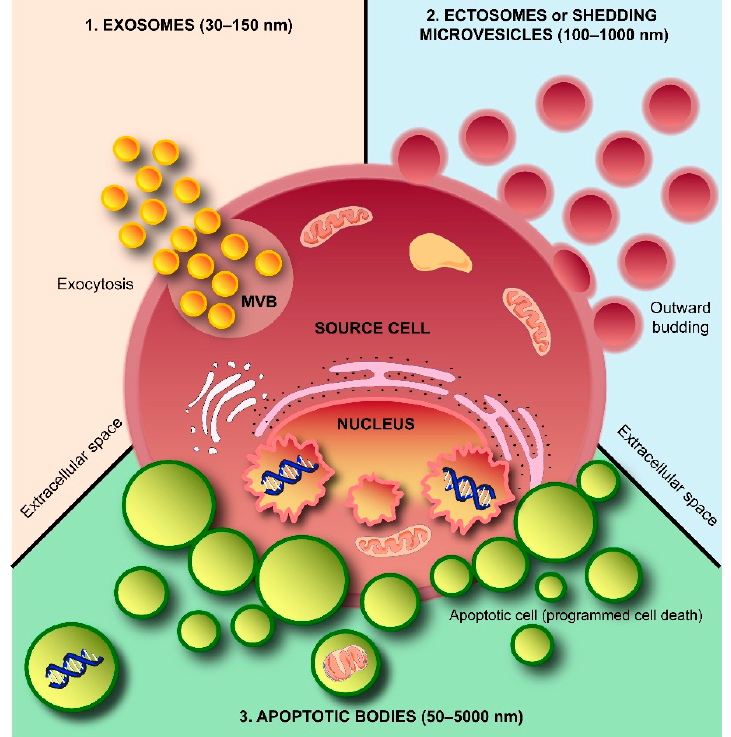
Figure 1. Schematic representation of subtypes of extracellular vesicles (EVs) released by a cell. Three subtypes of EVs, namely exosomes, shedding microvesicles or ectosomes and apoptotic bodies, are known to be secreted by a cell into the extracellular space. Exosomes are released by exocytosis, whereas shedding microvesicles or ectosomes are secreted by outward budding of the plasma membrane. Apoptotic bodies are released by dying cells during the later stages of apoptosis so that cell debris can easily be eliminated by neighboring and immune system cells. MVB: multivesicular body.